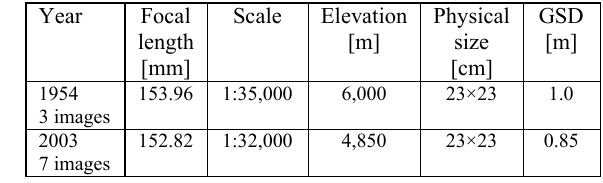
Table 1. Main characteristics of aerial photographs used.